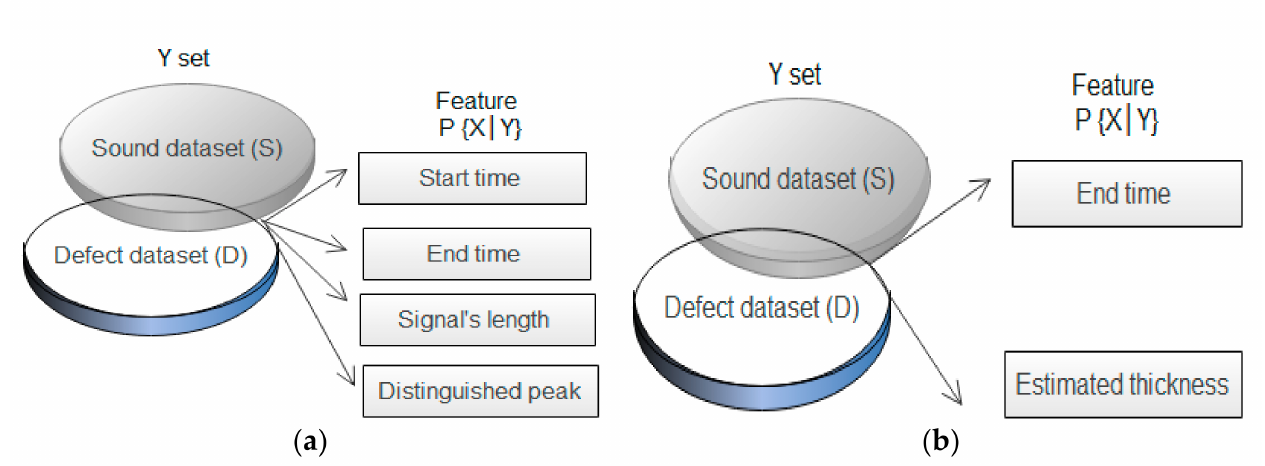
Figure 2. Naive Bayes classifiers model and the features ( a ) for preprocessed IE signals, ( b ) for preprocessed IE signals, and result of frequency approach based on raw IE signals.